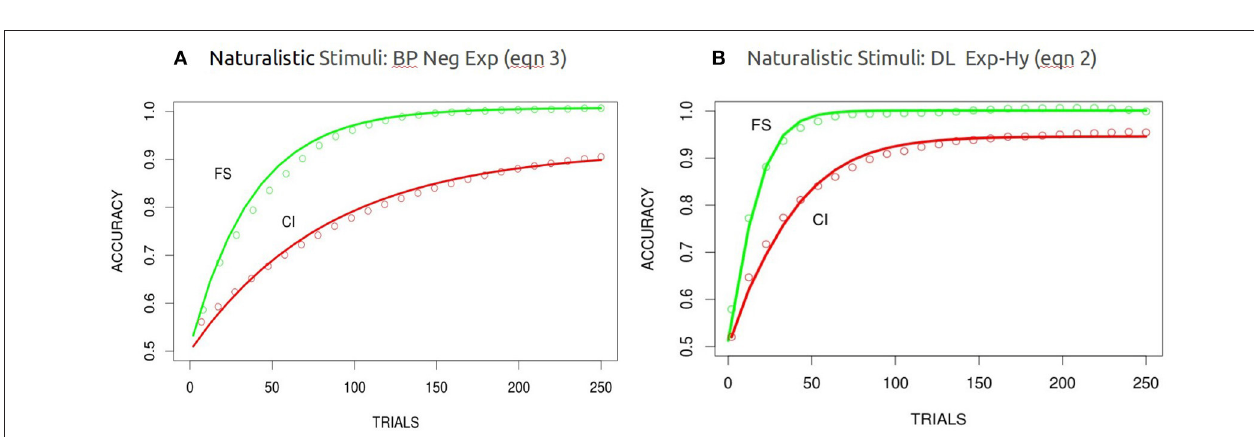
FIGURE 5 | Modeling of the FS (green) and CI (red) conditions with the low dimensional Kruschke (1993) stimuli for BP (A) and DL (B) over 10 repetitions.